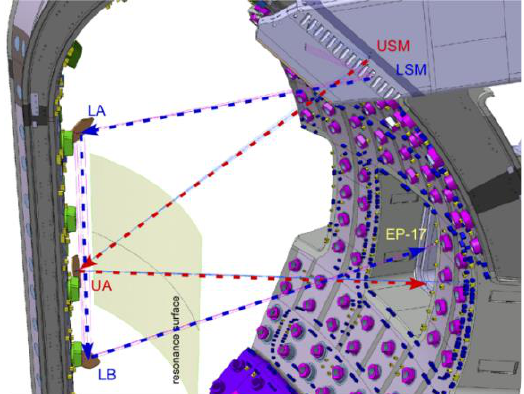
Fig. 1. First Plasma EC beam configuration. In blue are the lower beams launched by the LSM of the UL-16 and redirected to the resonance layer below the plasma null thanks to the LA and LB focusing mirrors. In red are the upper beams launched by the USM and refocused by the UA mirror to cross the resonance layer above the plasma null. The residual non- absorbed power of the beams will be attenuated in the beam dump located in the EP-17.